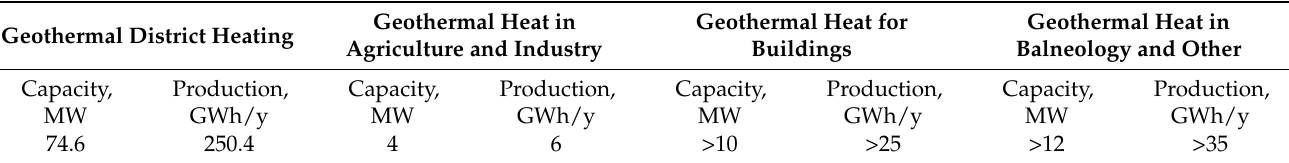
Table 4. Present deep geothermal district heating plants and other uses for heating in 2018 [87].